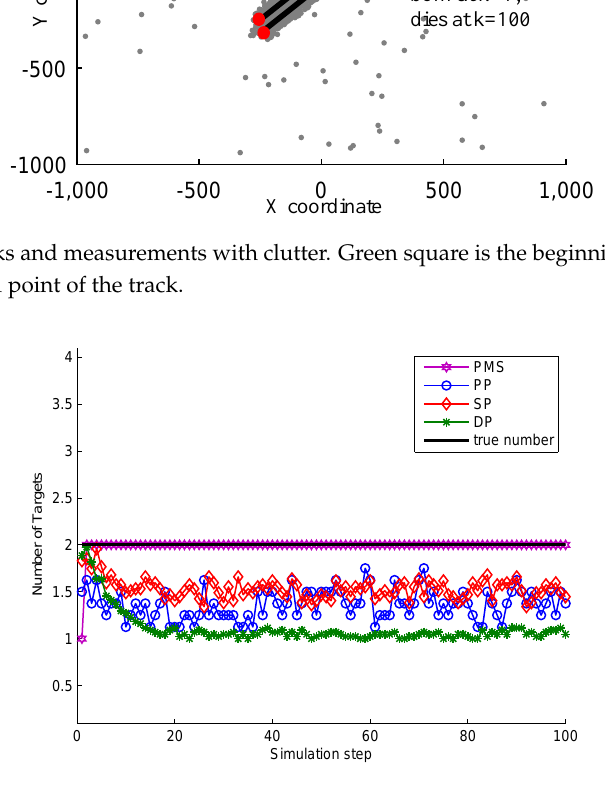
Figure 9. The comparison of four approaches in target number